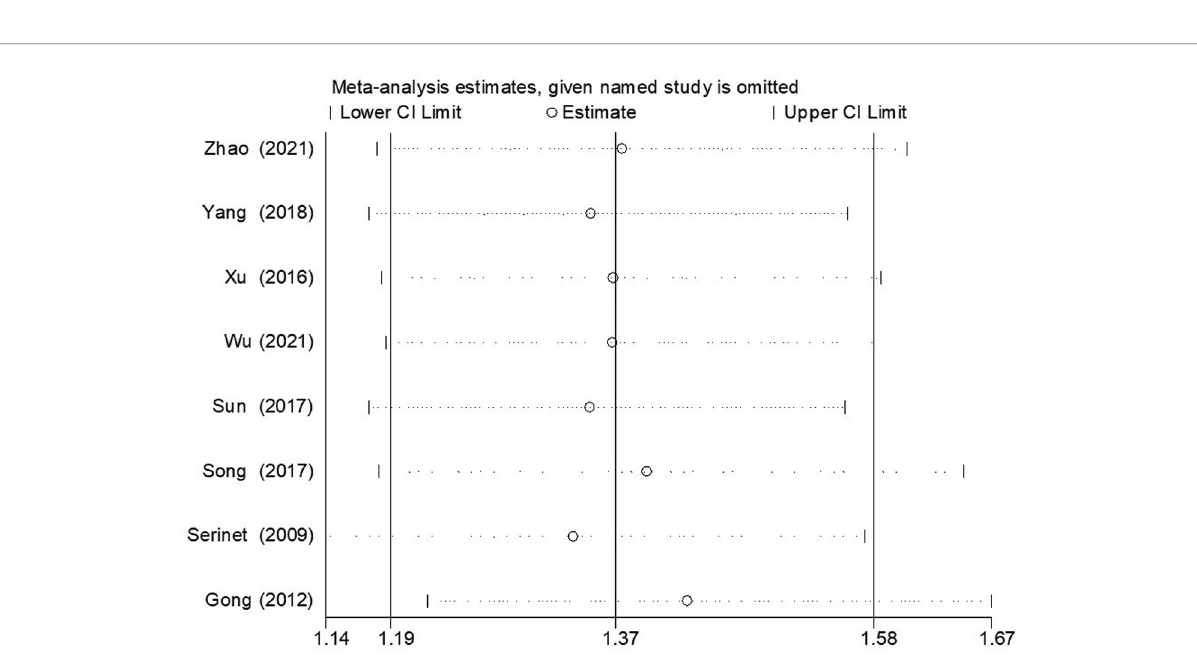
FIGURE 7 The result of sensitivity analysis regarding the assessment of NLSR of ≤ 90 days vs. >90 days group. NLSR, native liver survival